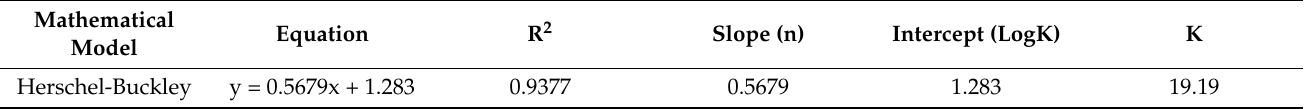
Table 5. Equation, coefficient of determination (R 2 ), slope and intercept values of the linear regressions obtained by fitting the rheogram’s data to the Herschel–Buckley mathematical model.